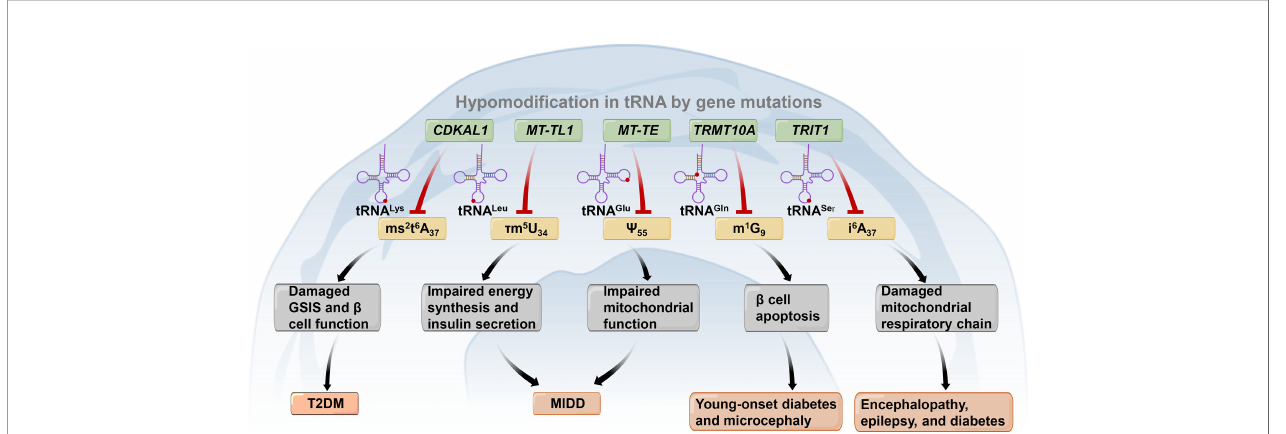
FIGURE 3 | Gene mutations (shown in the blue box) lead to tRNA hypomodi fi cations (shown in the yellow box) associated with diabetes and other metabolic diseases. CDKAL1 , CDK5 regulatory subunit associated protein 1-like 1; TRMT10A , tRNA methyltransferase 10 homolog A; TRIT1 , tRNA